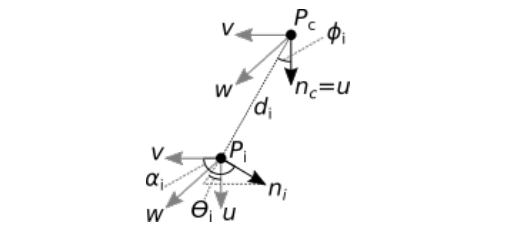
Figure 1. Point Pair Descriptor